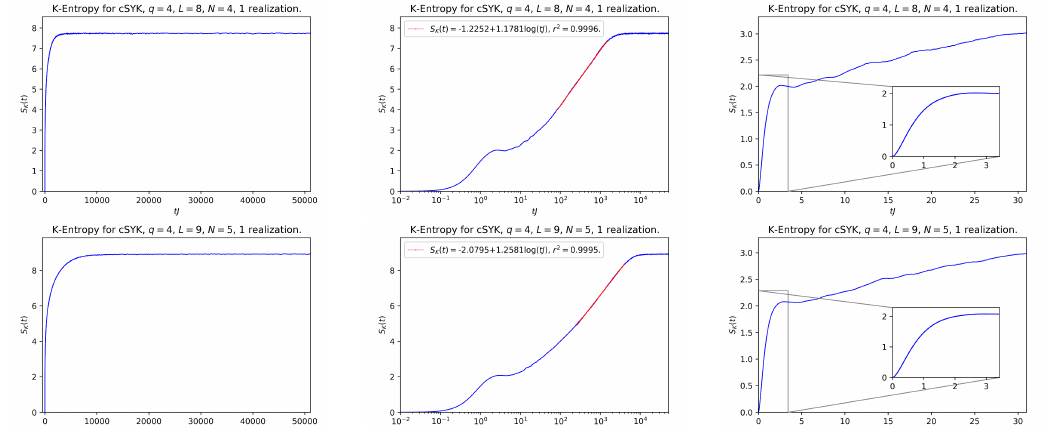
Figure 6 . Results for K-entropy for L = 8 , N = 4 and L = 9 , N = 5 . Top row: results for L = 8 ; for exponentially long time scales in linear (left panel) and logarithmic (middle panel) scale along the horizontal axis, and for early times (right panel). The saturation value is near L = 8 . Bottom Row: results for L = 9 ; for exponentially long time scales in linear (left panel) and logarithmic (middle panel) scale along the horizontal axis, and for early times (right panel). The saturation value is near L = 9 .